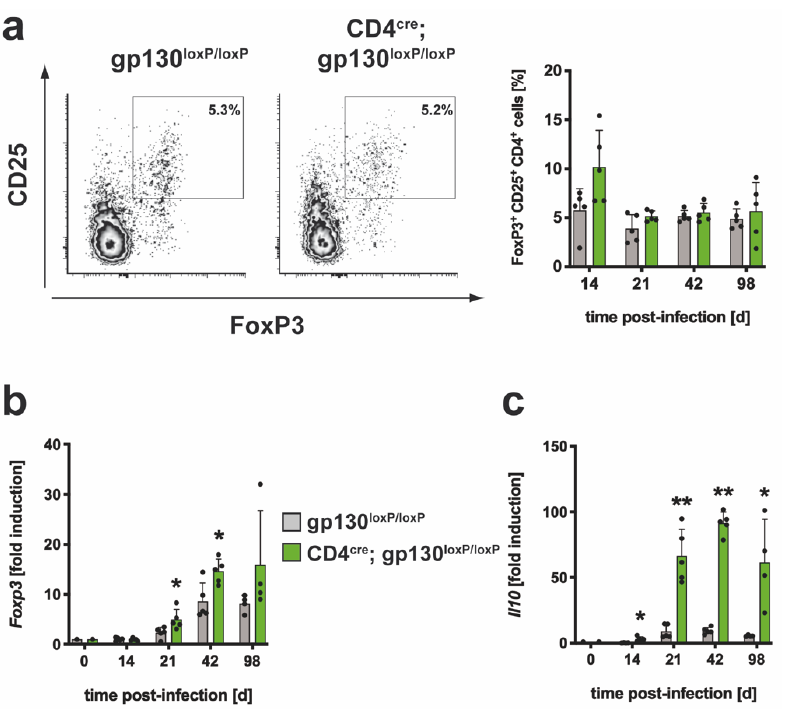
Figure 6. The regulatory immune response in Mtb-infected CD4 cre ; gp130 loxP/loxP mice. gp130 loxP/loxP (grey symbols) and CD4 cre ; gp130 loxP/loxP mice (green symbols) were infected with approximately 100 CFU Mtb via the aerosol route. At the indicated time points, lungs were removed and further processed. ( a ) The relative amount of the FoxP3 + CD25 + population within the CD4 + T cells was determined in single cell suspensions of lungs by flow cytometry. Representative density plots of FoxP3 + CD25 + CD4 + T cells on day 42 and frequencies of FoxP3 + CD25 + CD4 + T cells during the course of infection are shown. ( b , c ) After reverse transcription of isolated lung RNA, gene expression of ( b ) Foxp3 and ( c ) Il10 was quantified by real-time RT-PCR based on gene expression in uninfected mice. Mean values with standard deviations of 5 mice per group are shown. One repre- sentative experiment of two is shown. Data were statistically analyzed using the Mann–Whitney test defining differences between cre-negative littermates and CD4 cre ; gp130 loxP/loxP mice as significant (*, p ≤ 0.05; **, p ≤